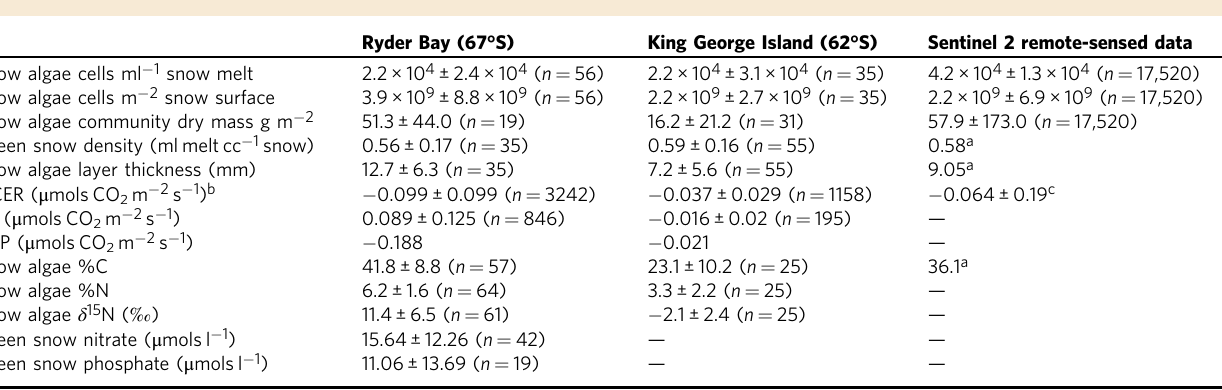
Table 1 Snow algae